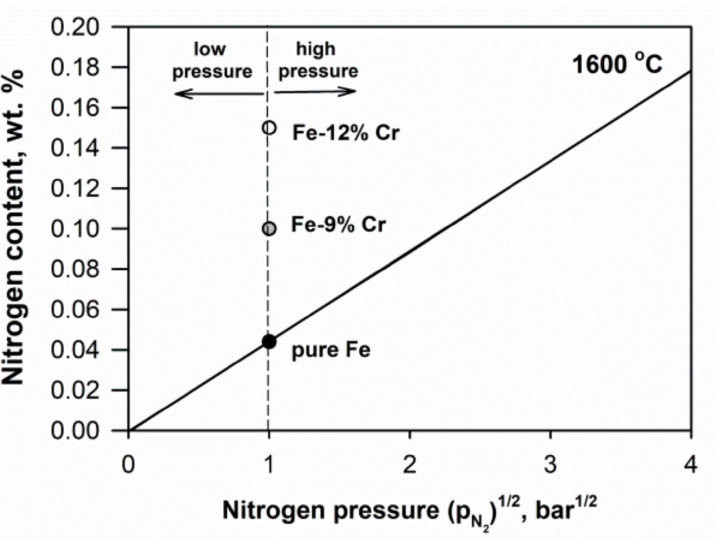
Figure 2. Effect of nitrogen partial pressure on nitrogen solubility in liquid pure Fe at 1600 ◦ C. Points for Fe–Cr alloys show the effect of Cr content on the nitrogen solubility. Data from [60]. Excess nitrogen content can be removed from molten steels according to Sievert’s law with vacuum. During vacuum induction melting, when vacuum and stirring are applied, dissolved nitrogen is adsorbed by bubbles and is flushed from the melt (Figure 3) [61]. Depending on required N content in steel, the pressure is